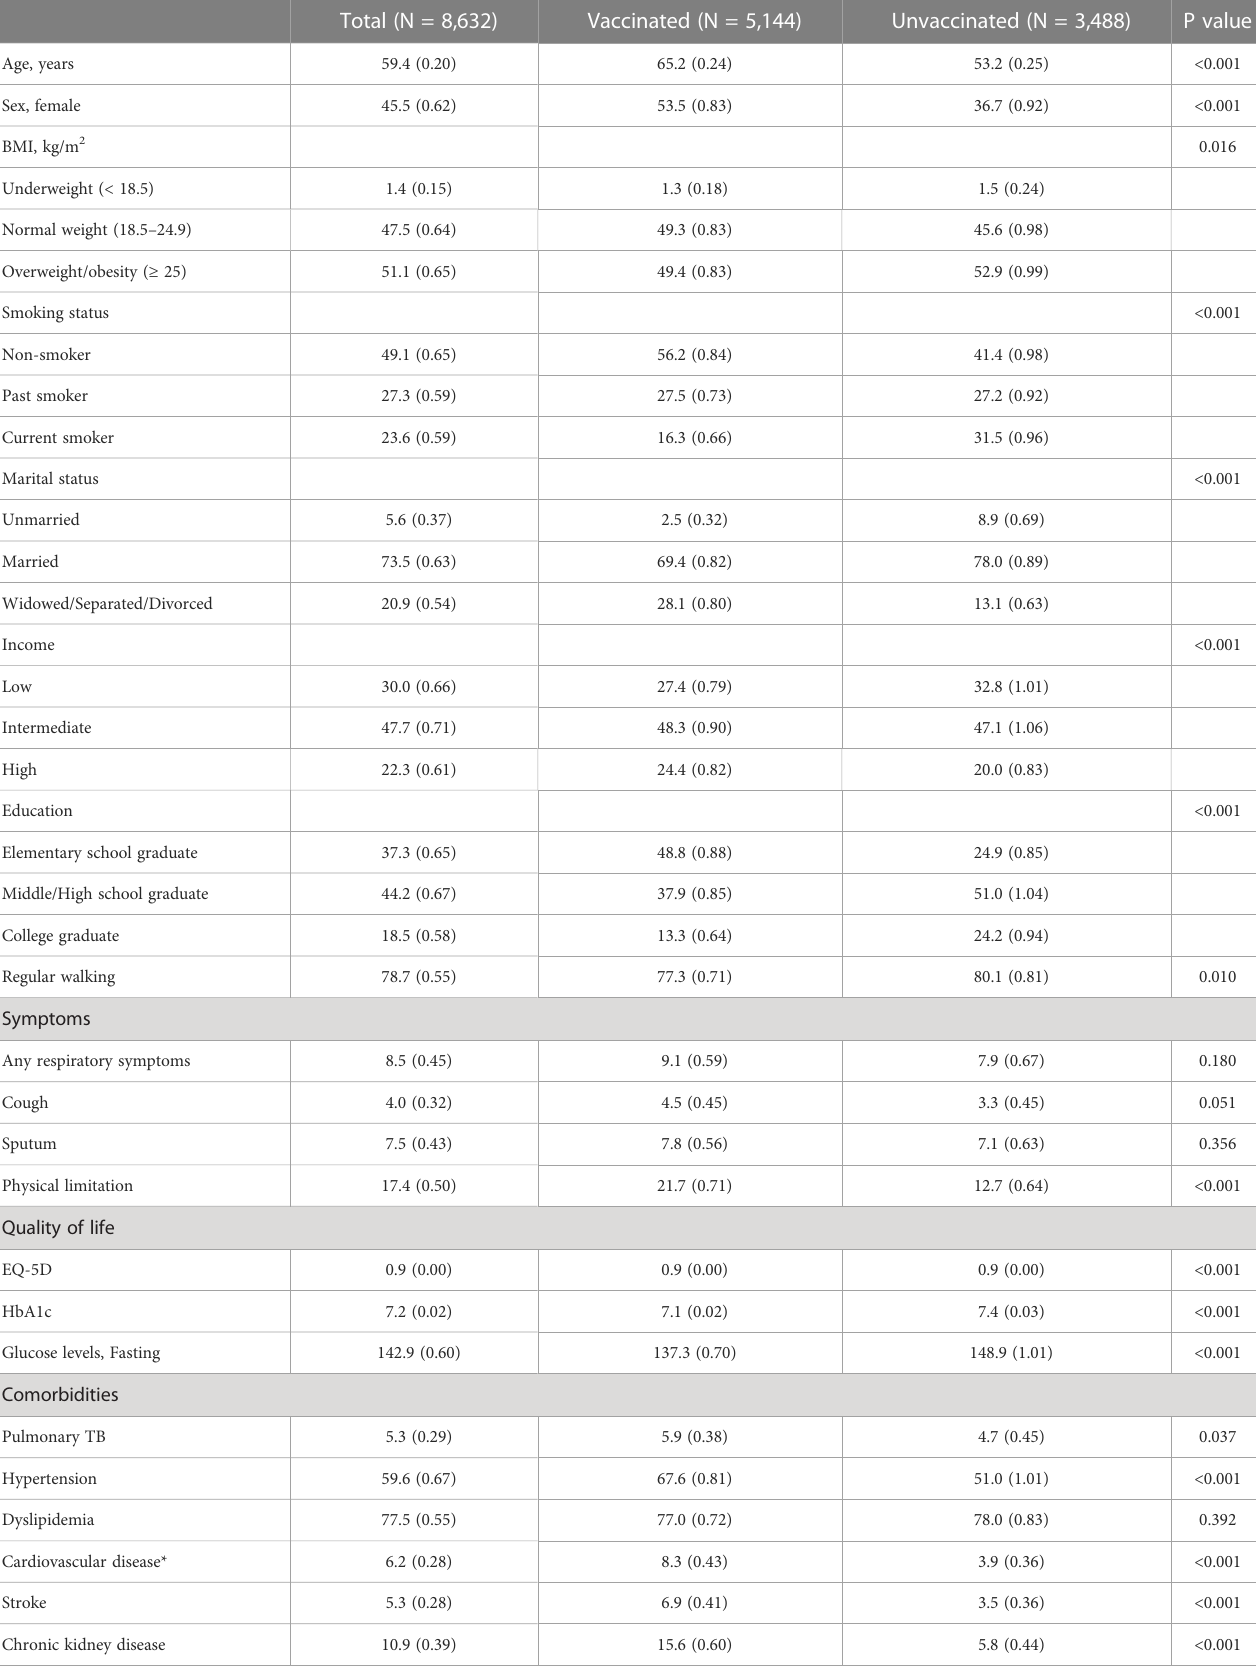
TABLE 1 Baseline characteristics of the study population in patients with diabetes